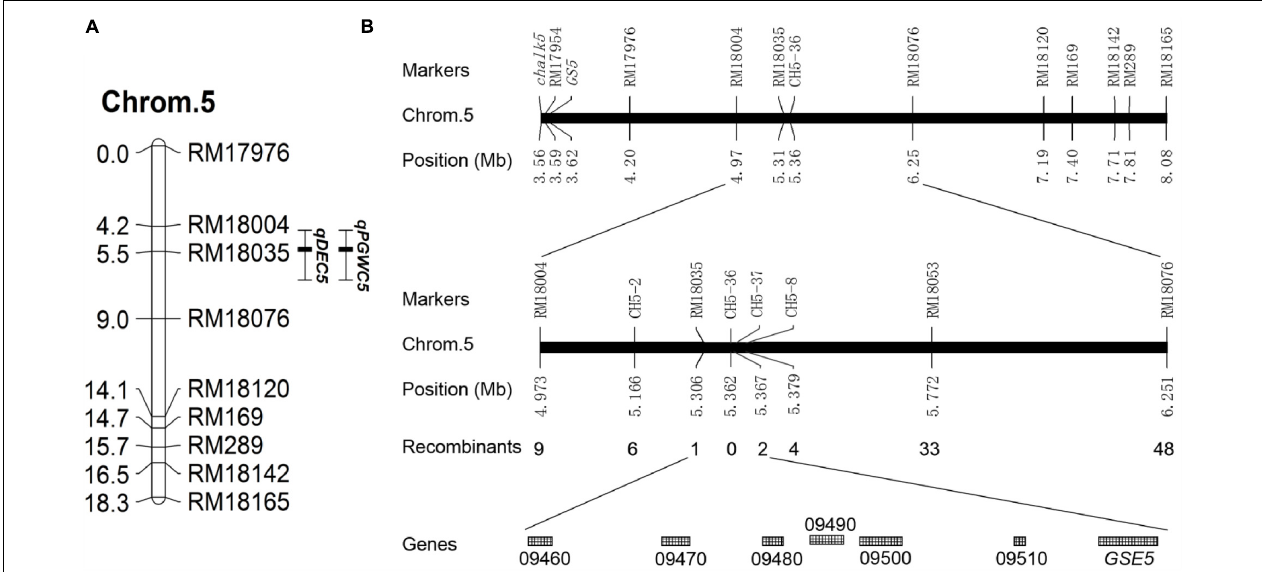
FIGURE 2 | Genetic linkage map and physical map. (A) Genetic linkage map. Chrom.5 indicates chromosome 5, the numbers on the left side are the genetic distances (cM), the numbers on the right side are the molecular marker names, qPGWC5 is a QTL for PGWC, and qDEC5 is a QTL for DEC. (B) Fine mapping of qDEC5 . “LOC_Os05g + the number” shown on the last line indicates the gene number in the rice gene annotation library of the Michigan State University (MSU) website (http://rice.plantbiology.msu.edu/).